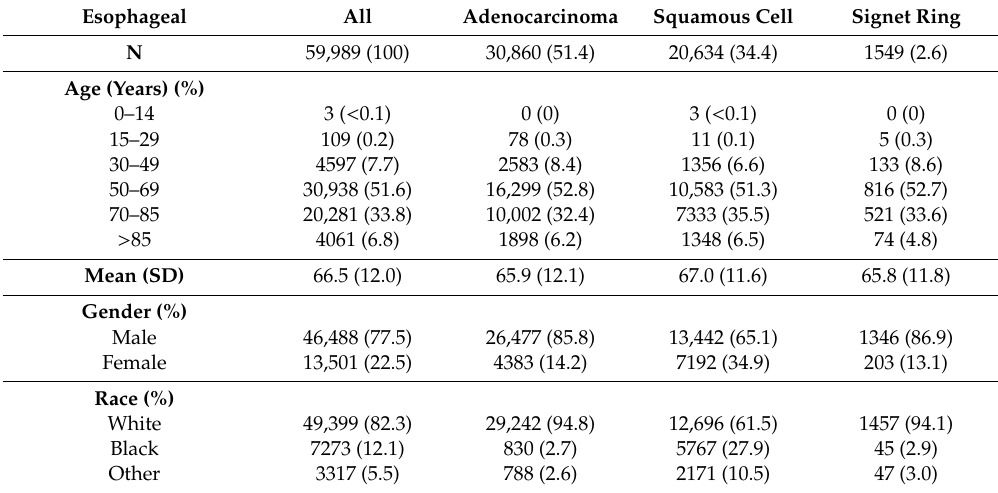
Table 5. Baseline demographics and clinical characteristics by histology for esophageal